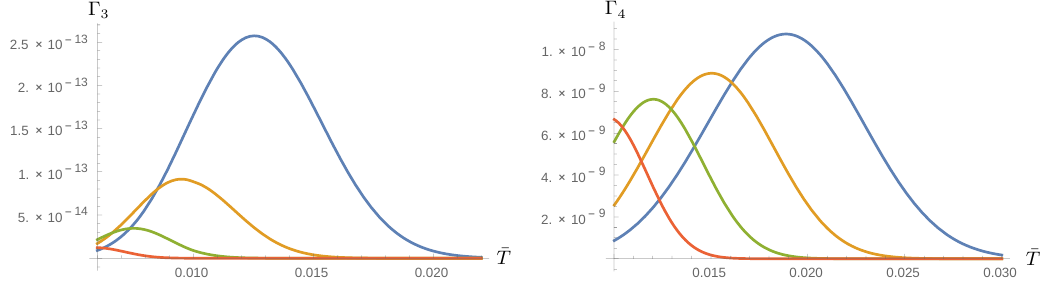
Figure 5 . Representative plots of the decay rate ¯Γ ≡ Γ /M 4 for g/ 10 6 = 1 (blue), 2 (orange), 4 KK (green), 8 (red), for the O(3) (left) and O(4) (right) configurations. values of g , the rate for the O(4) bubble dominates on the one for the O(3) bubble for those values of ¯ T for which it is defined, namely for ¯ T . 0 . 06 . Thus, at such small temperatures, the decay is much more likely to happen via quantum rather than thermal